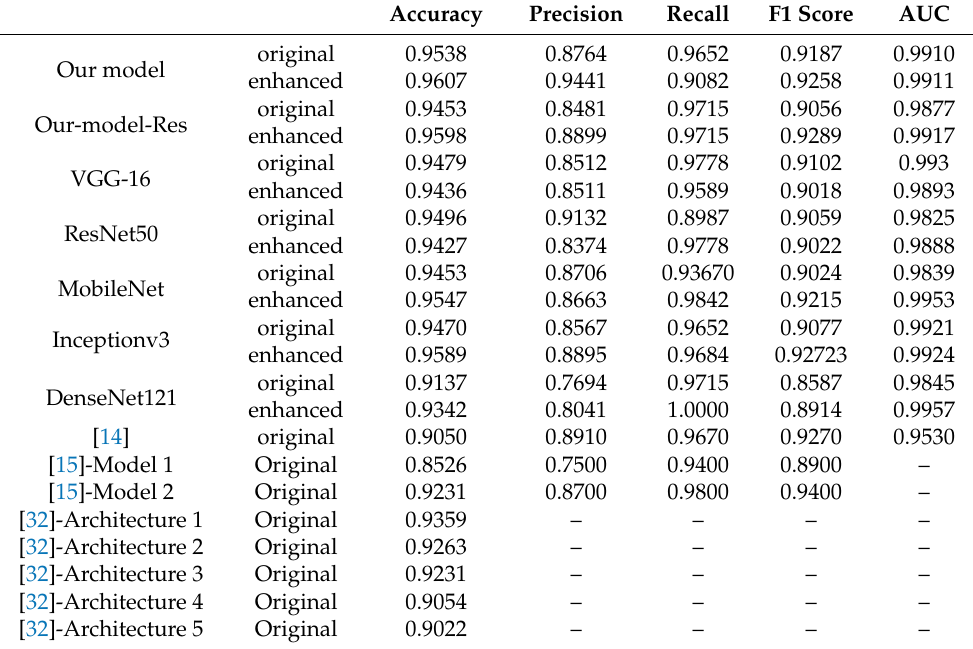
Table 4. Summary of performance of different models with input shape 224 and loss function